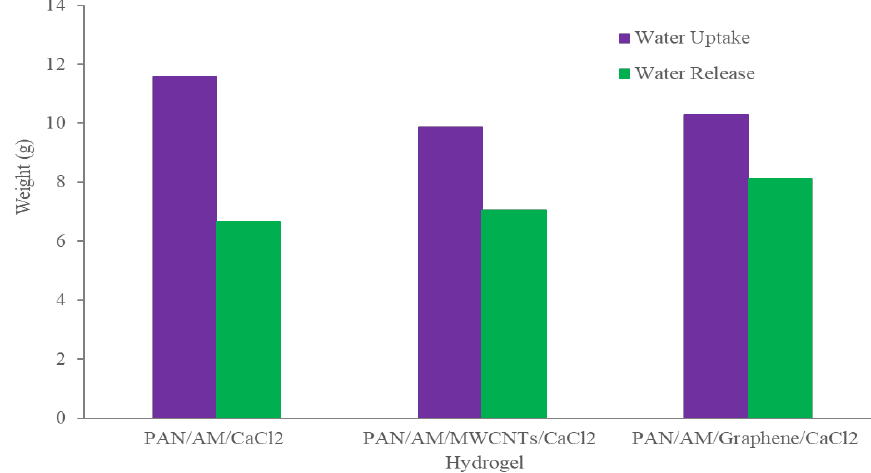
Figure 8. Atmospheric water collection using hydrogel without a magnifying glass.